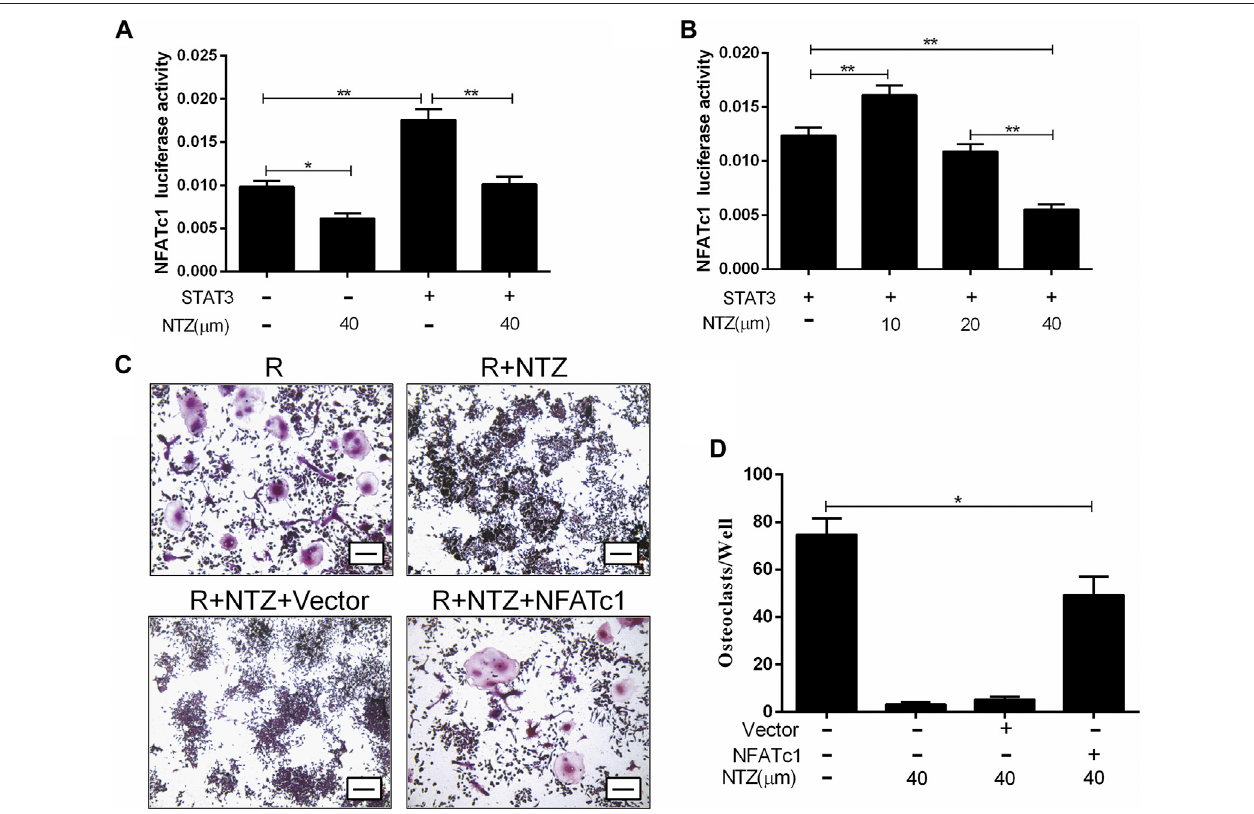
FIGURE7| NitazoxanideimpairedSTAT3activityonNFATc1transcription. (A,B) RAW264.7cellsweretransfectedwithorwithoutSTAT3,togetherwithNFATc1- Luc, and were subsequently treated with 40 µM NTZ (A) or a range of NTZ concentrations (B) . NFATc1 luciferase activity was analyzed. (C) RAW264.7 cells were transfectedwithNAFTc1orcontrolplasmid,andthenwerestimulatedwithRANKL(50 ng/ml)inthepresenceof40 µMNTZfor7 days.TRAPstainingwasperformedat day 7. Scale bar (cid:2) 100 µm. (D) The number of TRAP + osteoclasts was counted under light microscopy. Error bars represent mean ± SD from three independent experiments. NTZ (cid:2) nitazoxanide; R (cid:2) RANKL. * p value ＜ 0.05, ** p value ＜